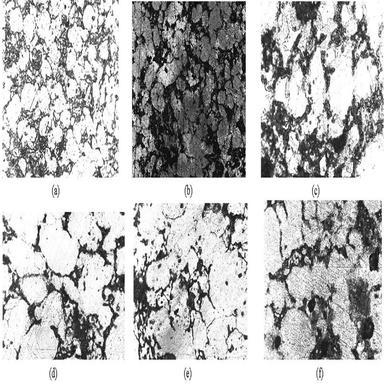
Optical microstructure of (a) 3 h pellet before etching 200-, (b) 3 h after etching 200-, (c) 1.5 h after etching 500-, (d) 2 h after etching 500-, (e) 4 h after etching 500-, (f) 5 h after etching 500-.